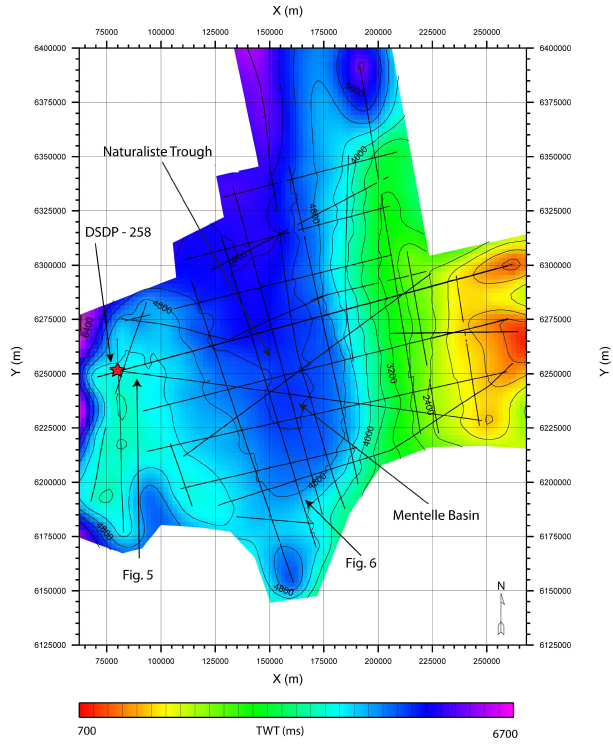
Fig. 8. TWT map of the basal reflection that defines the Base Albian